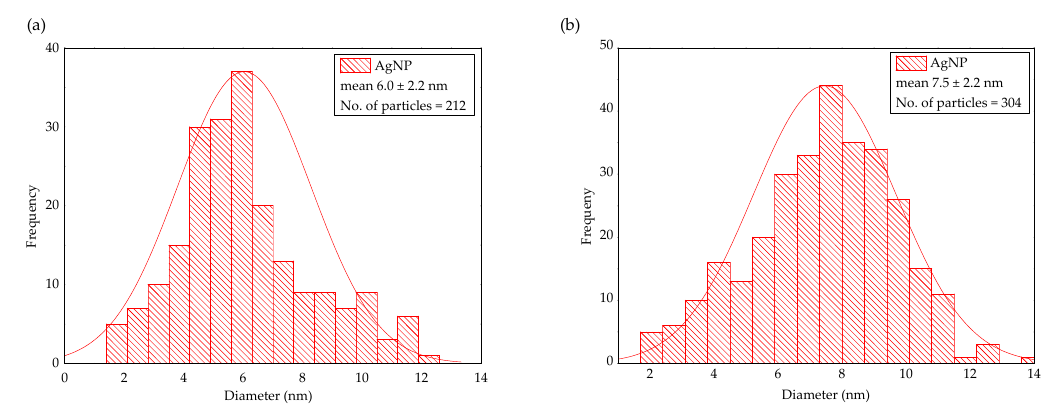
Figure 9. Particle size distribution of AgNPs for samples: ( a ) EPS-0.60-1 mM-180 µ E; ( b ) EPS-0.60-1 mM-70 µ E.